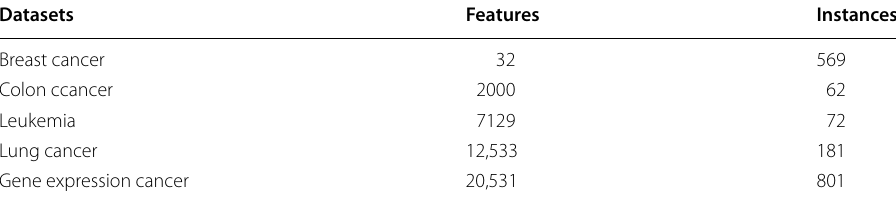
Table 6 Dataset description